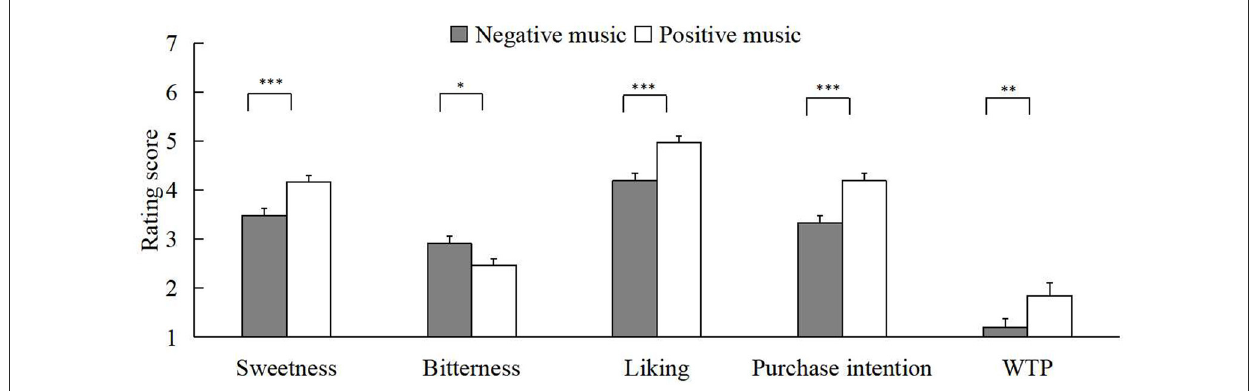
FIGURE1 The main effect of emotional music on the five dimensions. Note that error bars show the standard errors of the means, * p < 0.05, ** p < 0.01. and *** p < 0.001.